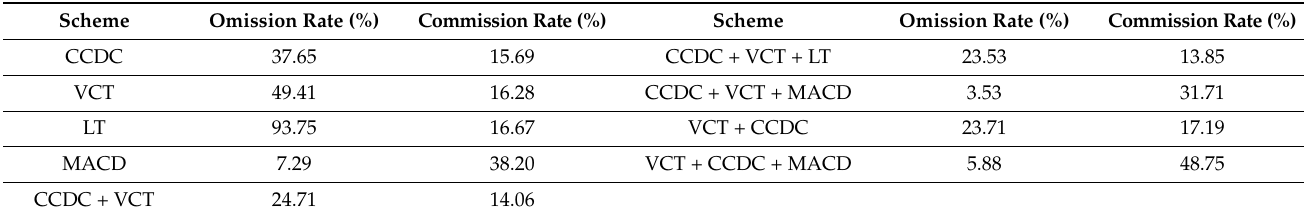
Table A2. Omission and commission rate errors for individual algorithms and ensemble